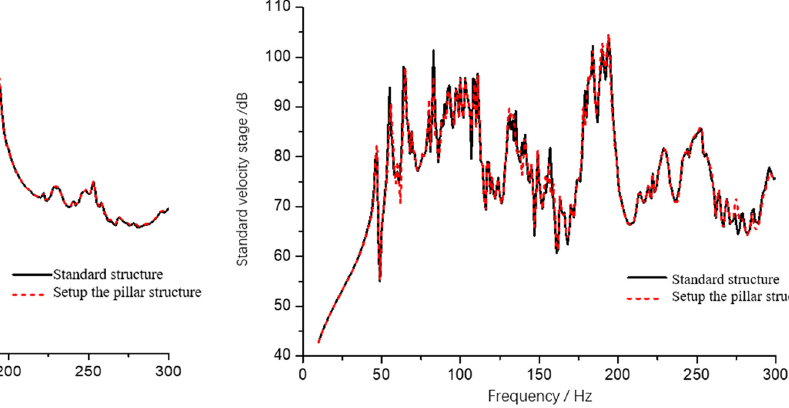
Figure 10: Mean square velocity of A cabin deck. Figure 11: Mean square velocity of B cabin